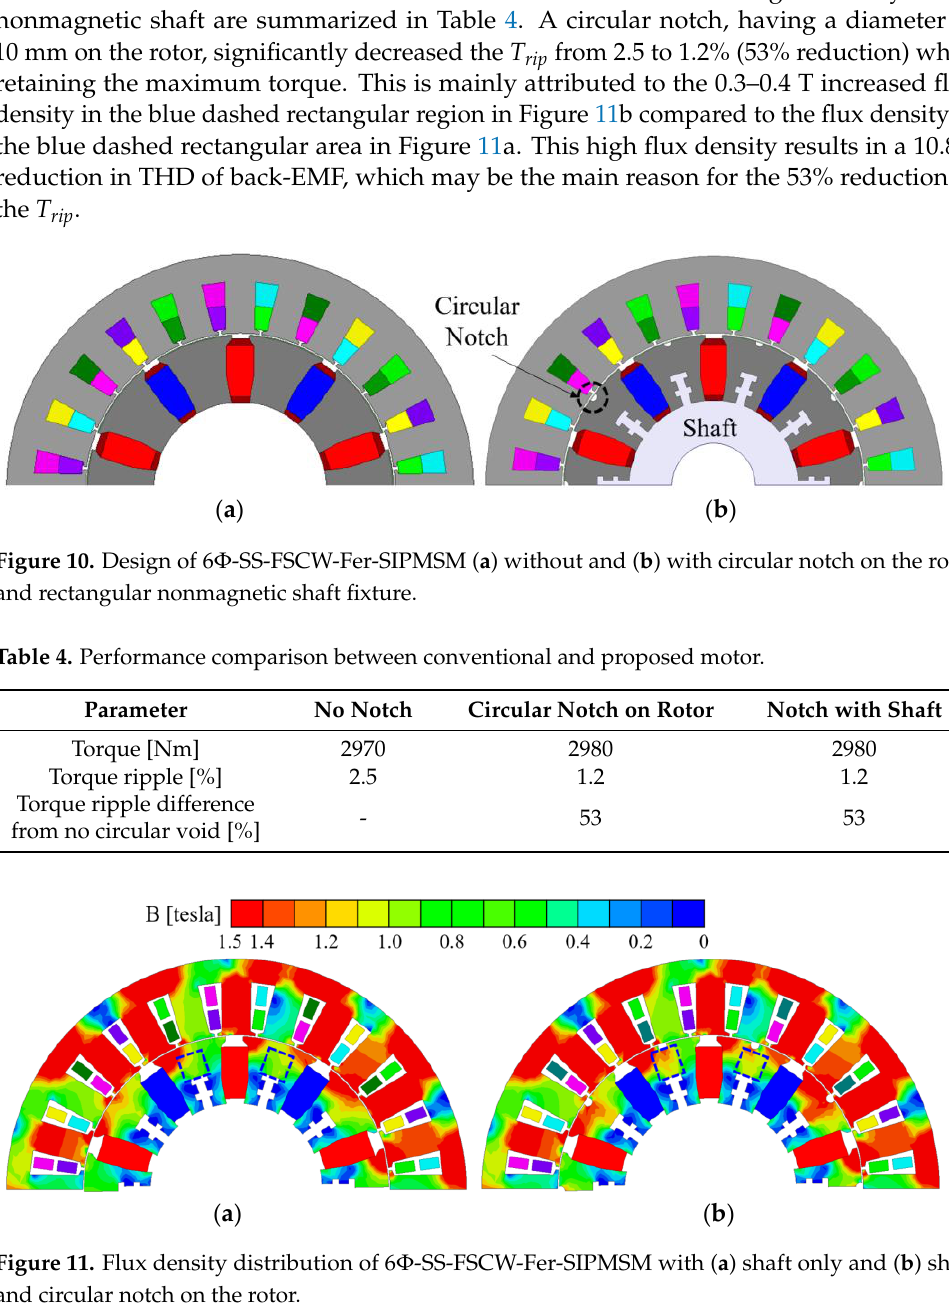
( b ) Figure 12. ( a ) Maximum torque and torque ripple performance and ( b ) cogging torque with respect to the diameter of the circular notch used on the rotor.